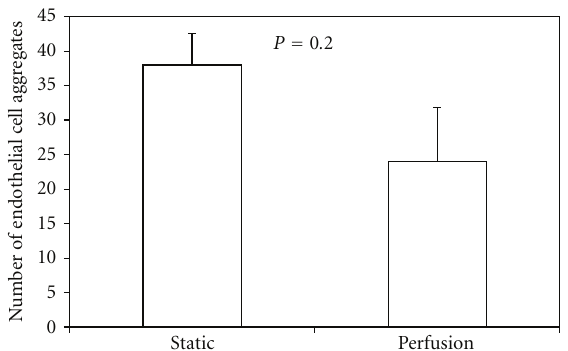
Figure 9: The average number of endothelial cell aggregates did not change in three-dimensional sca ff olds subjected to perfusion flow compared to static conditions.